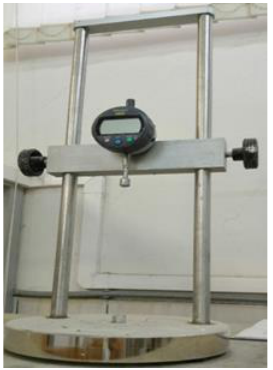
Figure 3. Sample strain measurement device.